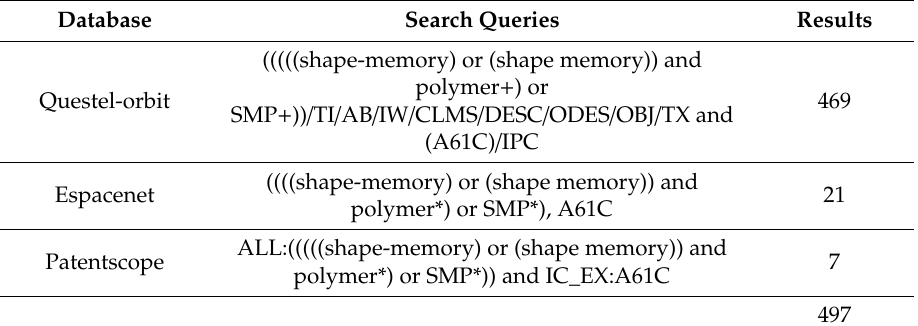
Table 5. Patent database search